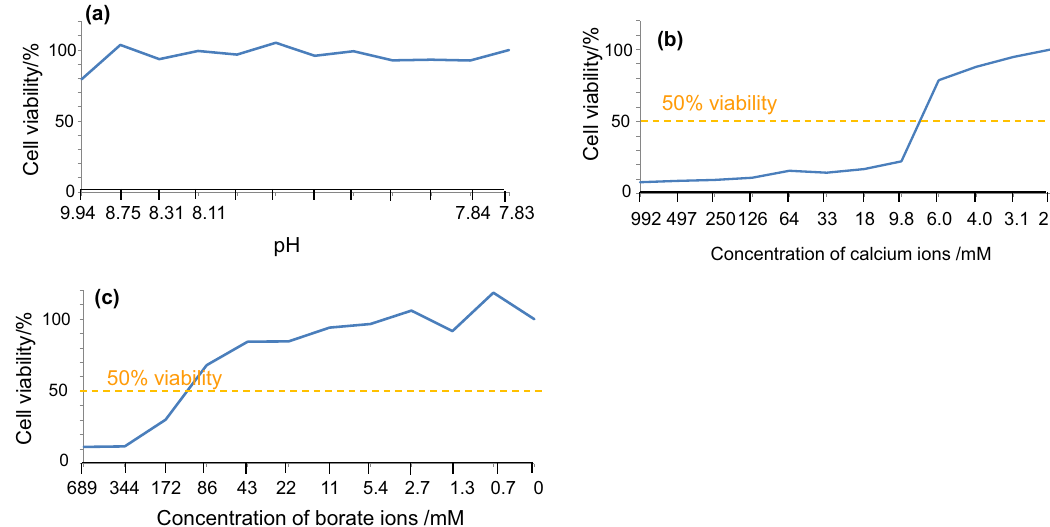
Fig. 7 Effect of ( a ) pH and concentrations of ( b ) calcium, and ( c ) borate ions in the medium on cell viability of L929 cells